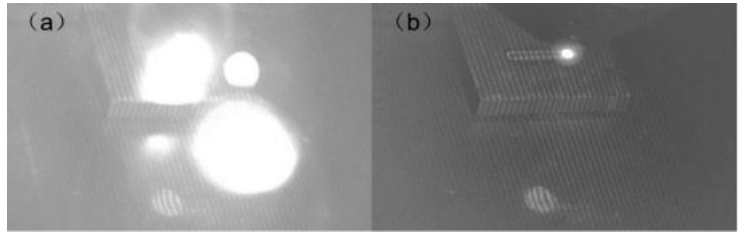
Figure 6. Comparison of fringe image quality obtained by using ( a ) one and ( b ) two filters.